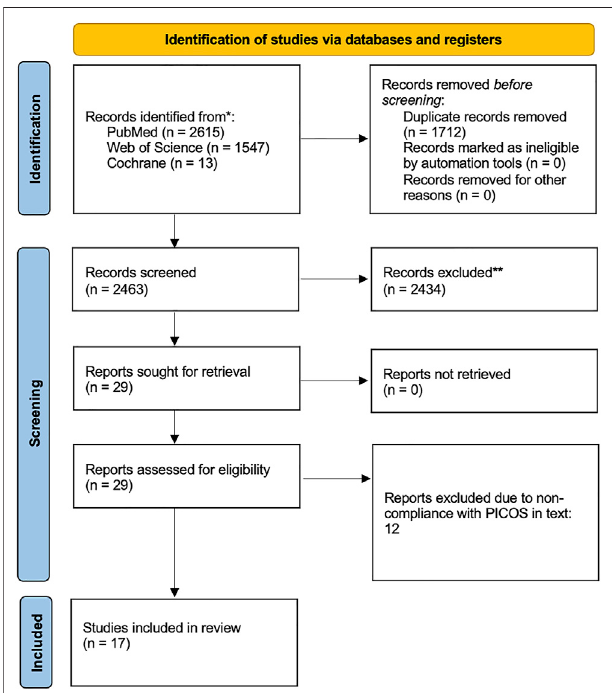
FIGURE 2 | Paper Screening Flow. **Papers excluded due to lack of adherence to PICOS.